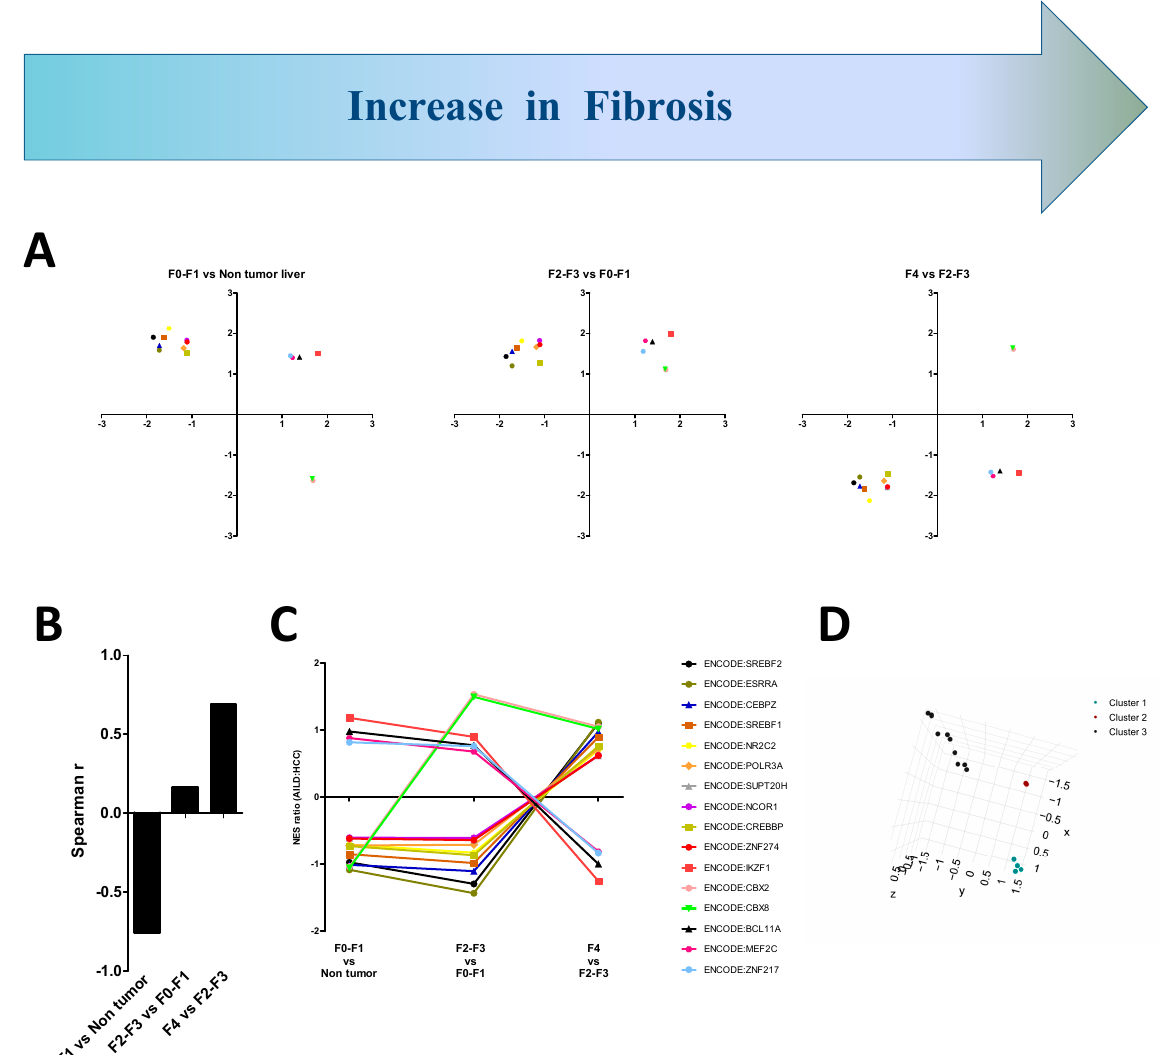
Figure 5. Distinct transcriptomic signatures of AILD are associated with the fibrotic patterns of carcinomatous livers. ( A ) 2D scatter plots depicting the enrichment scores of transcription factor modules along AILD vs. healthy liver (x axis) and advanced stage vs. previous stage of fibrosis (y axis) comparisons for different grades of fibrosis in HCC. Enrichment scores were obtained following GSEA against “TF.Target.ENCODE” database on iDEP.91. Moving rightwards along the x axis indicates increased expression in AILDs and moving upwards along the y axis indicates increased expression in HCC. ( B ) bar plot showing Spearman rank correlation coefficient between AILD and HCC for each stage of fibrosis. ( C ) kinetics of shift in NES ratio between AILD and HCC for each transcription factor module across all stages of fibrosis are shown with line diagrams. ( D ) k means cluster plot showing clusters of transcription factor modules in a 3D space based on their NES ratio along progressive stages of fibrosis. x, y and z axes represent F0–F1 vs. non tumor, F2–F3 vs. F0–F1 and F4 vs. F2–F3 transitions, respectively. Distribution of transcriptional modules in each cluster is shown in Figure S6. The color and signs of each transcription factor module (for A , C ) are shown at the right side of ( C ).